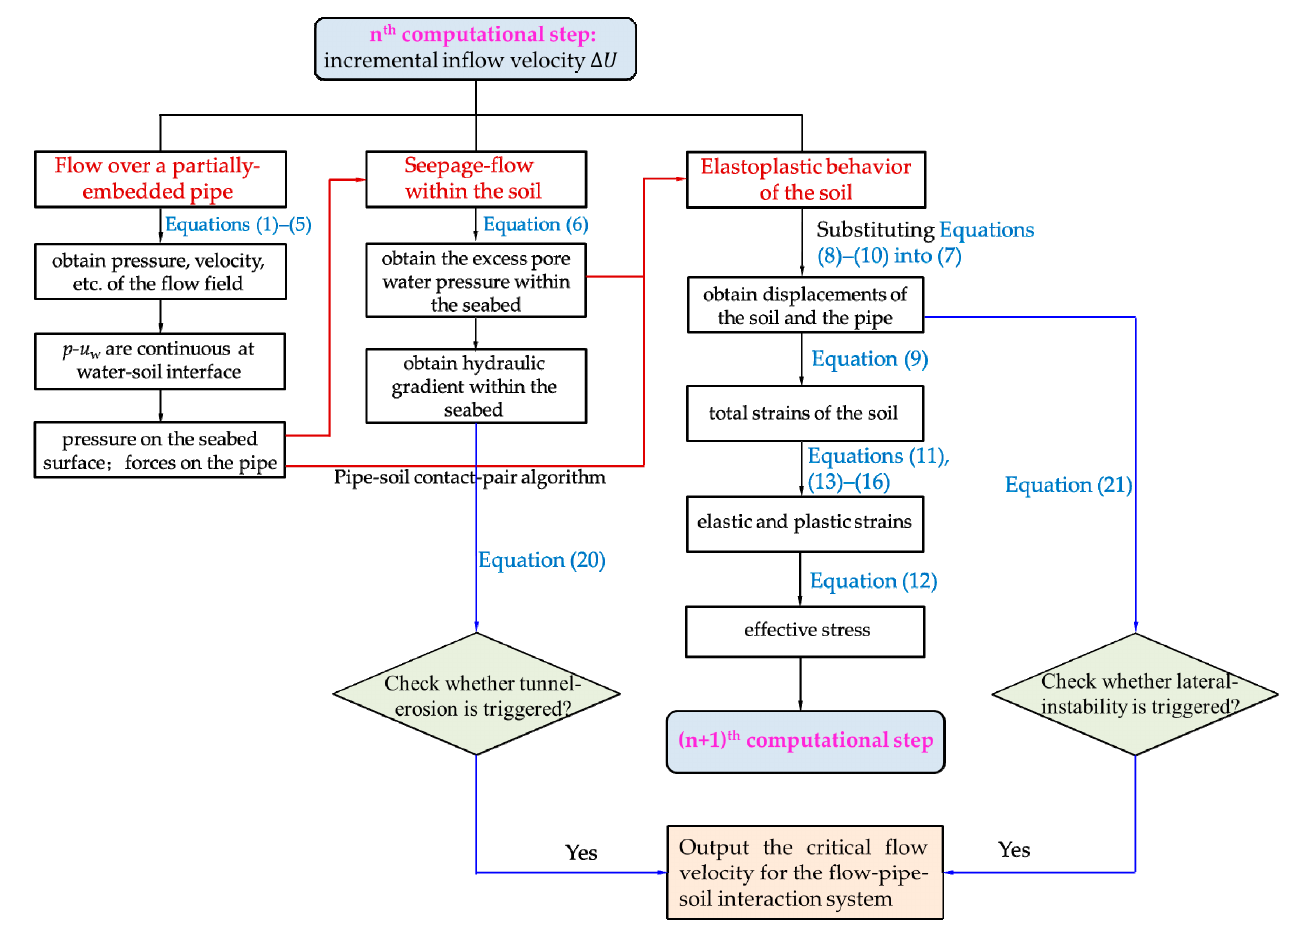
Figure 3. Coupling algorithm for the flow-seepage–elastoplastic model.